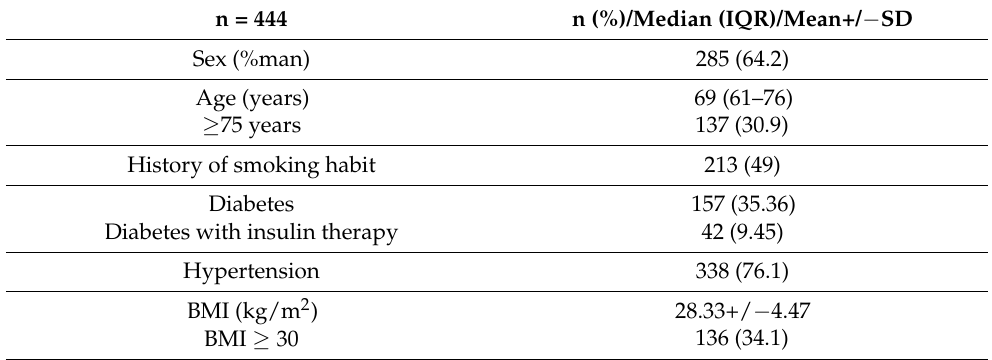
Table 2. Baseline